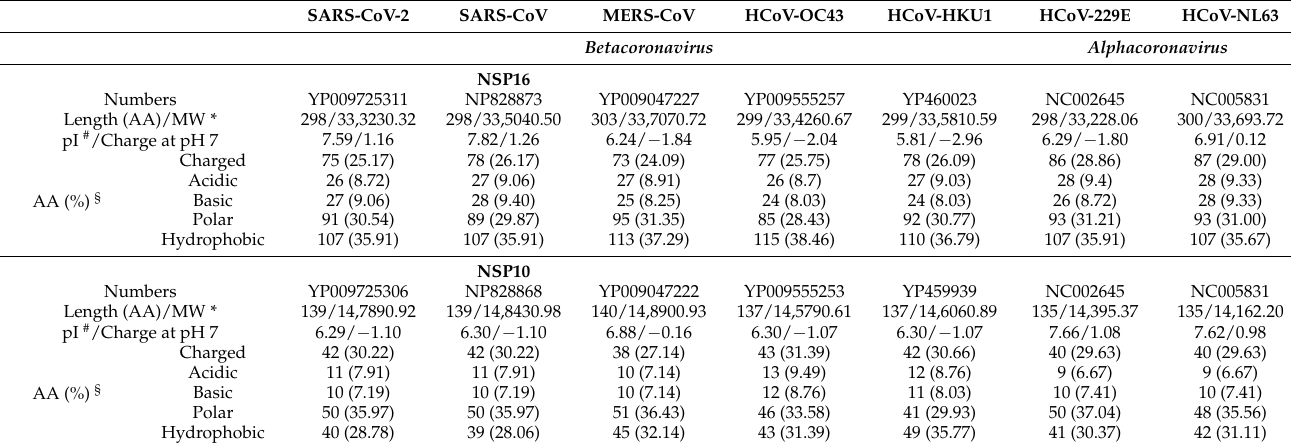
Table 1. Comparison of SARS-CoV-2 NSP16/NSP10 amino acid composition with that of other human